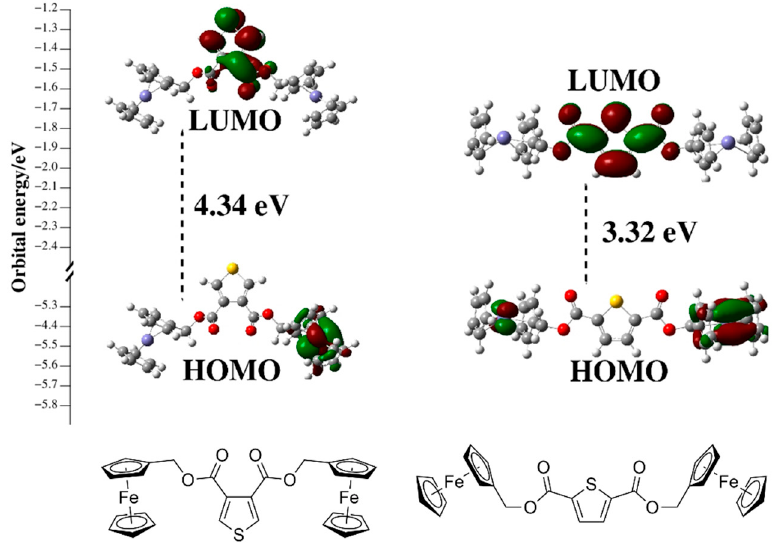
Figure 2. Frontier orbitals (HOMO and LUMO) for compounds 3 ( left ) and 5 ( right ), calculated at the B3LYP/6-31+G(d,p) and LANL2DZ level in dichloromethane, with isosurface 0.04. The HOMO- LUMO gap for both compounds is indicated in eV.